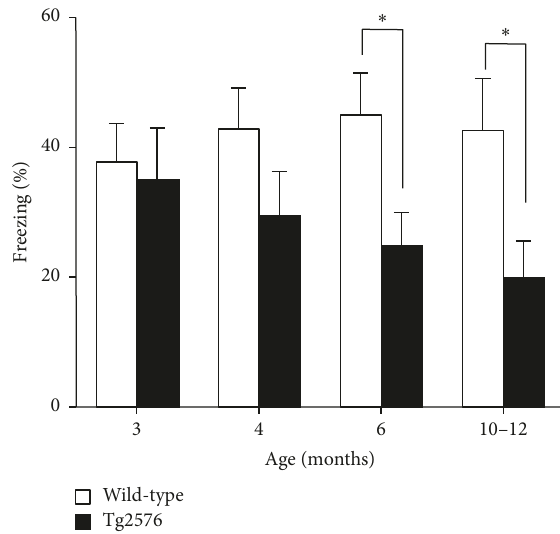
Figure 3: Contextual fear conditioning in the Tg2576 mice. The fear memory 24 hr after footshock was evaluated in Tg2576 mice (closed column, 𝑛 = 10 ) and their littermate control mice (open column, 𝑛 = 10 ). Tg2576 mice display intact contextual memory 24 hr later at 3 and 4 months of age. A significant impairment of contextual fear conditioning is observed, with lower levels of freezing to context in 6-month-old Tg2576 mice compared to controls. The impairment is also significant in 10-month-old Tg2576 mice. No differences were observed in freezing to context in control mice across all ages examined. Data points represent the mean ± SEM. ∗ 𝑝 < 0.05 versus the corresponding wild-type